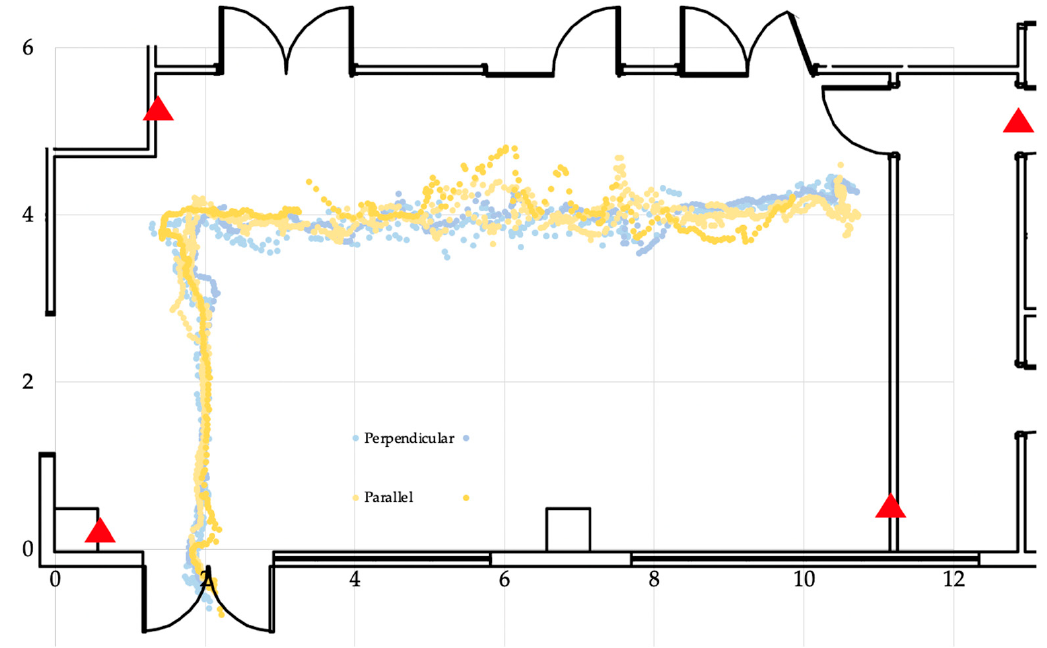
Table 5. Results from the sensitivity to orientation test.